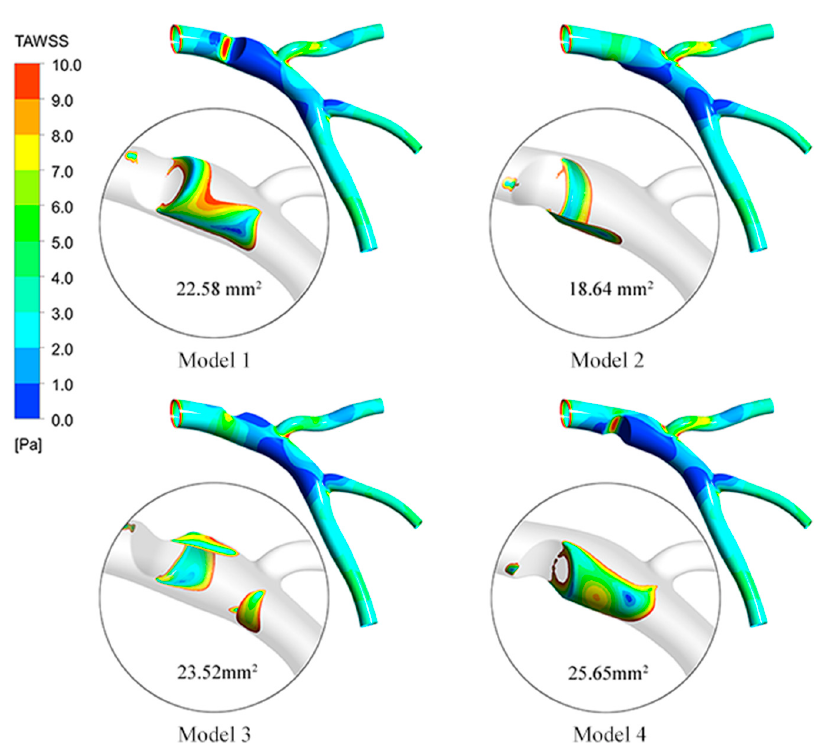
Figure 12. The TAWSS contours for the different models.